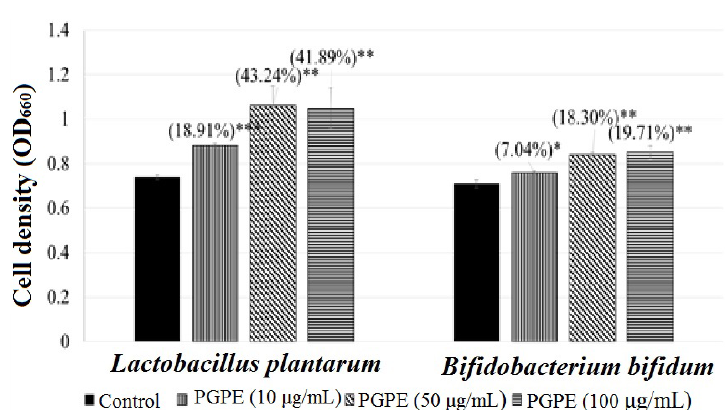
Figure 9. Growth promoting effect of Punica granatum peel extract on probiotic strains. Bacterial growth was measured as OD * p <0.05, ** p <0.01, *** p <0.001. PGPE: Punica granatum peel extract.